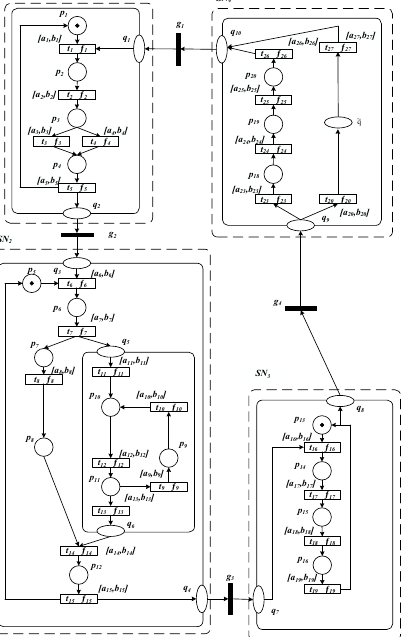
Figure 5. Embedded control system model of a smart restaurant Σ = {𝑁, 𝐹, 𝐺, 𝑀} .